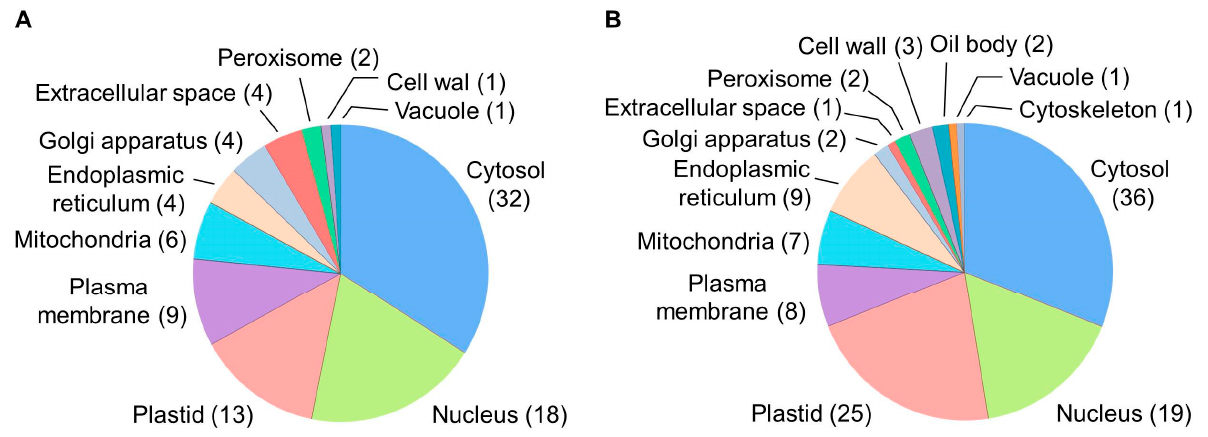
Figure 9. Prediction of the sub-cellular localization of proteins identified as up- ( A ) or downregulated ( B ) in Cucumis sativus transgenic roots overexpressing CsRALF34 . Numerical values indicate the numbers of proteins with locations predicted to specific compartments. The individual proteins annotated to speci fi c predicted compartments are listed in Supplementary Information S6.